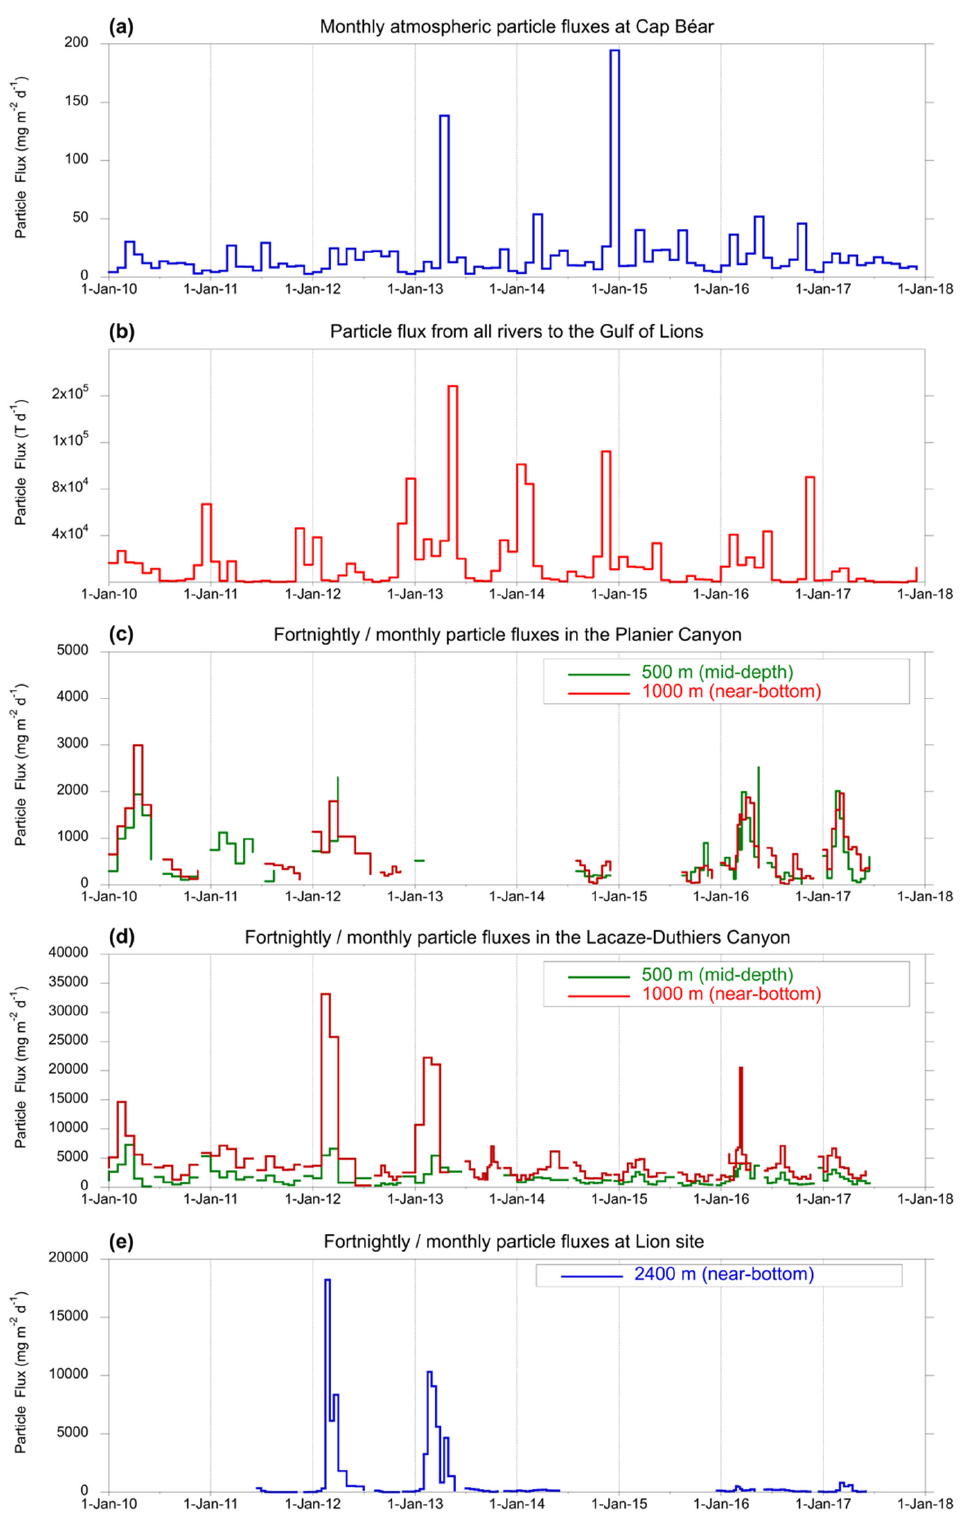
Figure 5. The 2010–2017 time series of the atmospheric, riverine, and oceanic particulate fluxes. ( a ) Atmospheric fluxes at Cap Béar; ( b ) aggregated river discharges; ( c ) particulate fluxes at 500 and 1000 m deep in the Planier Canyon; ( d ) particulate fluxes at 500 and 1000 m deep in the Lacaze- Duthiers Canyon; ( e ) particulate fluxes at 2400 m in the deep basin (Lions). Note the change in scale for the flux in the canyons and in the basin. See Figure 1 for the location of the sites.